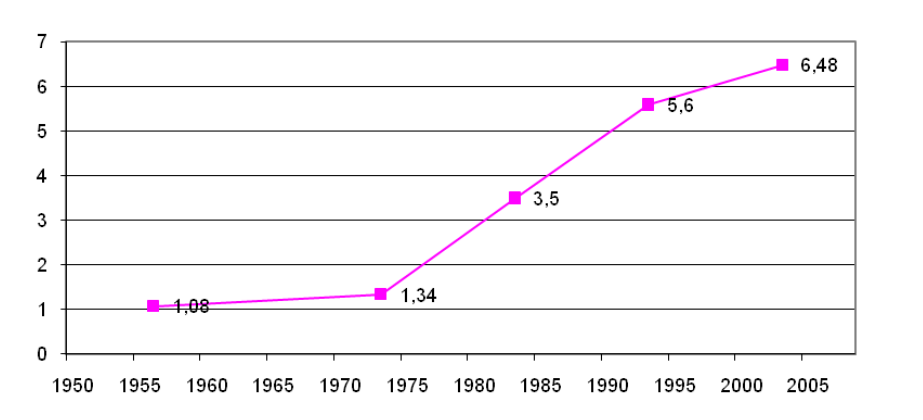
Figure 4: Total population levels (in millions) in Darfur, 1956-2003.